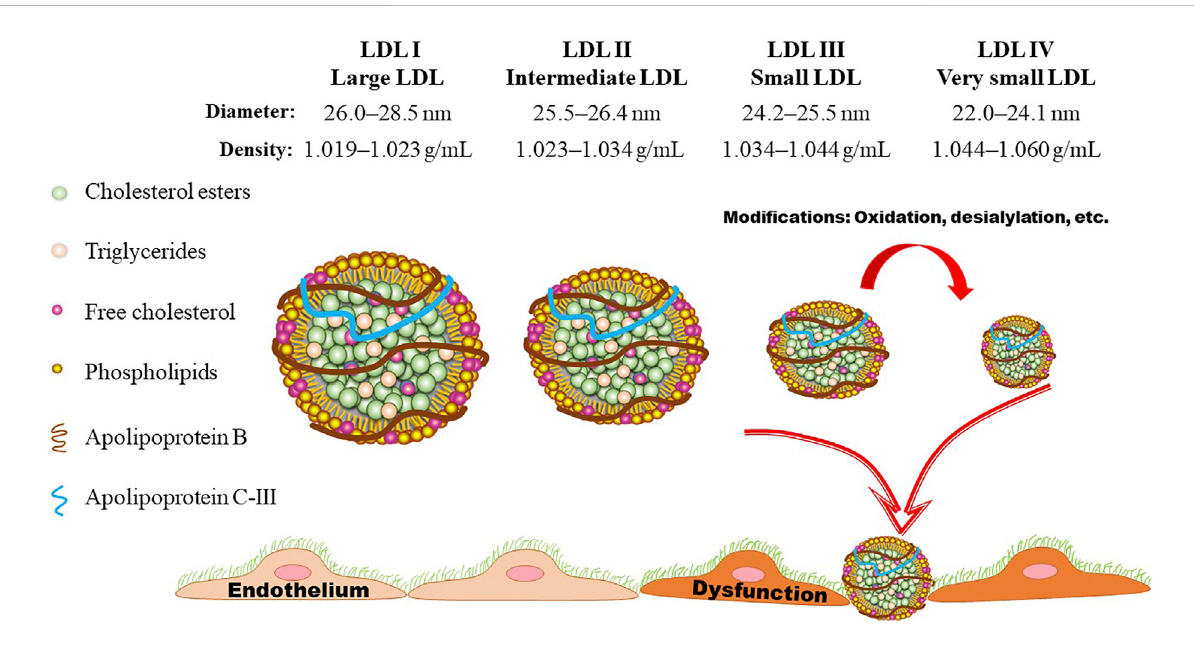
LDL subclasses. Based on the fl otation rate, LDL particles can be divided into four subclasses by means of ultracentrifugation. Gradient gel electrophoresis is another commonly used method for separation of LDL subclasses according to the size, shape, and electric charge. LDL particles are generally divided into three or four subclasses according to their size (diameter). Presently, LDL III and LDL IV are generally assigned as small dense LDL (sdLDL), which is lack of anti-oxidant component and easily to be oxidized, initiating the onset and progression of atherosclerotic cardiovascular